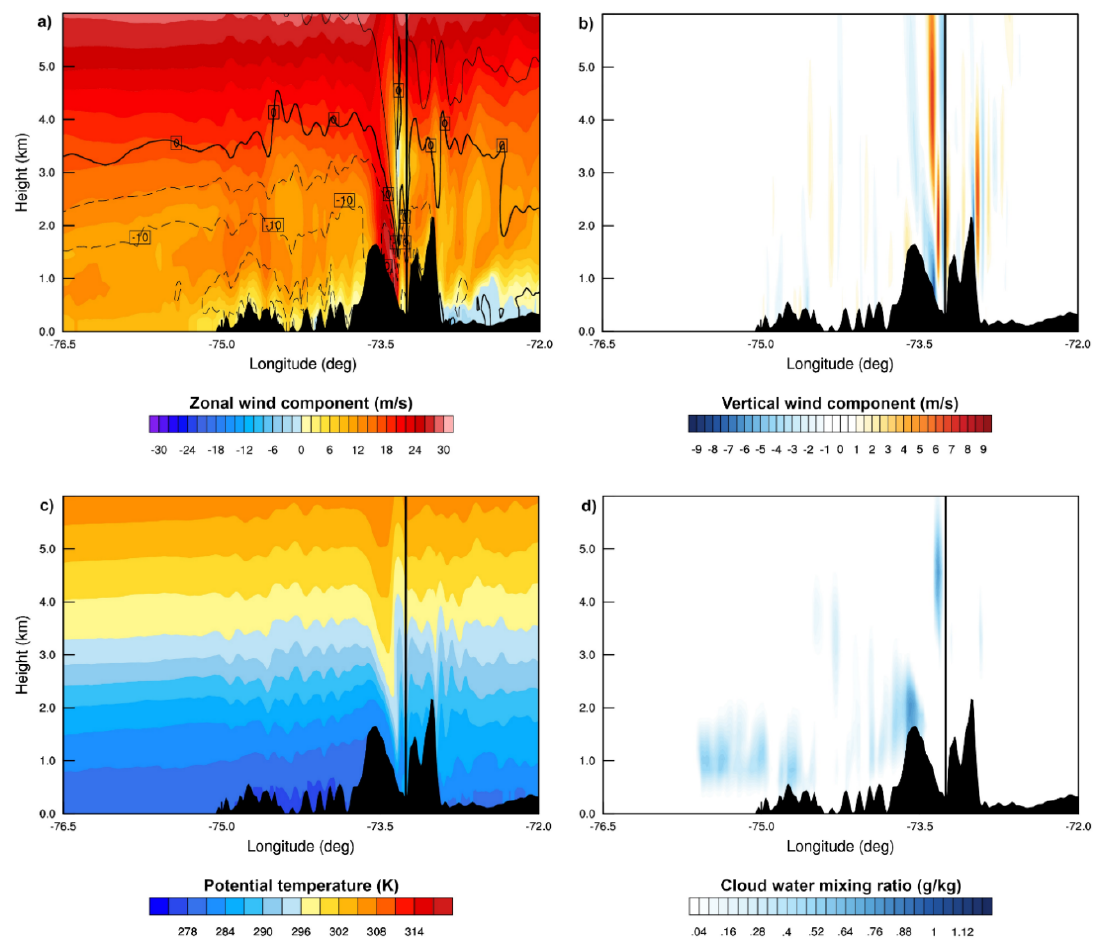
Figure 11. Vertical cross section (90° angle) of ( a ) zonal (color scheme) together with meridional (contour lines) wind component, ( b ) vertical wind component (positive values reveal upward motion, negative values reveal downward motion), ( c ) potential temperature, and ( d ) cloud water mixing ratio for the subcritical case on 5th October 2018 12:00. The black line indicates the location of NG. Data are derived from WRF.